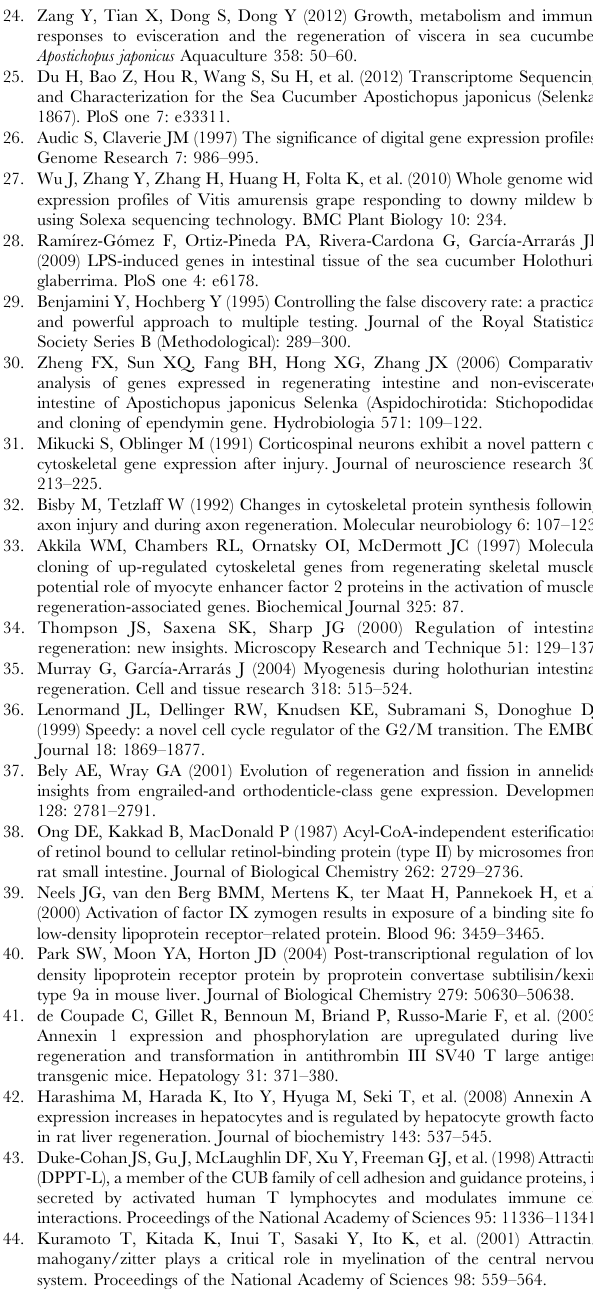
Table S8 All genes unique to 3, 7, 14 and 21dpe respectively.